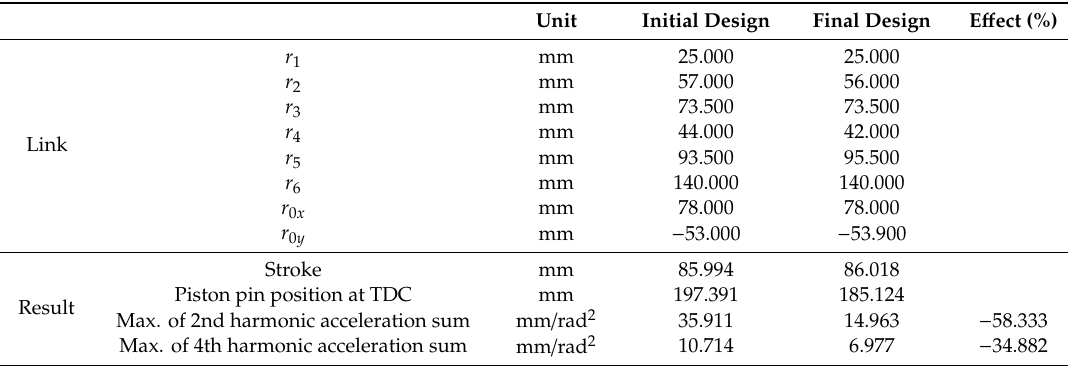
Figure 9. Adjusted stroke and maximum value of vertical second harmonic acceleration sum in each case: ( a ) adjusted stroke and ( b ) maximum vertical second harmonic acceleration sum in the in-line four-cylinder engine. Table 7. Comparison of the initial and final